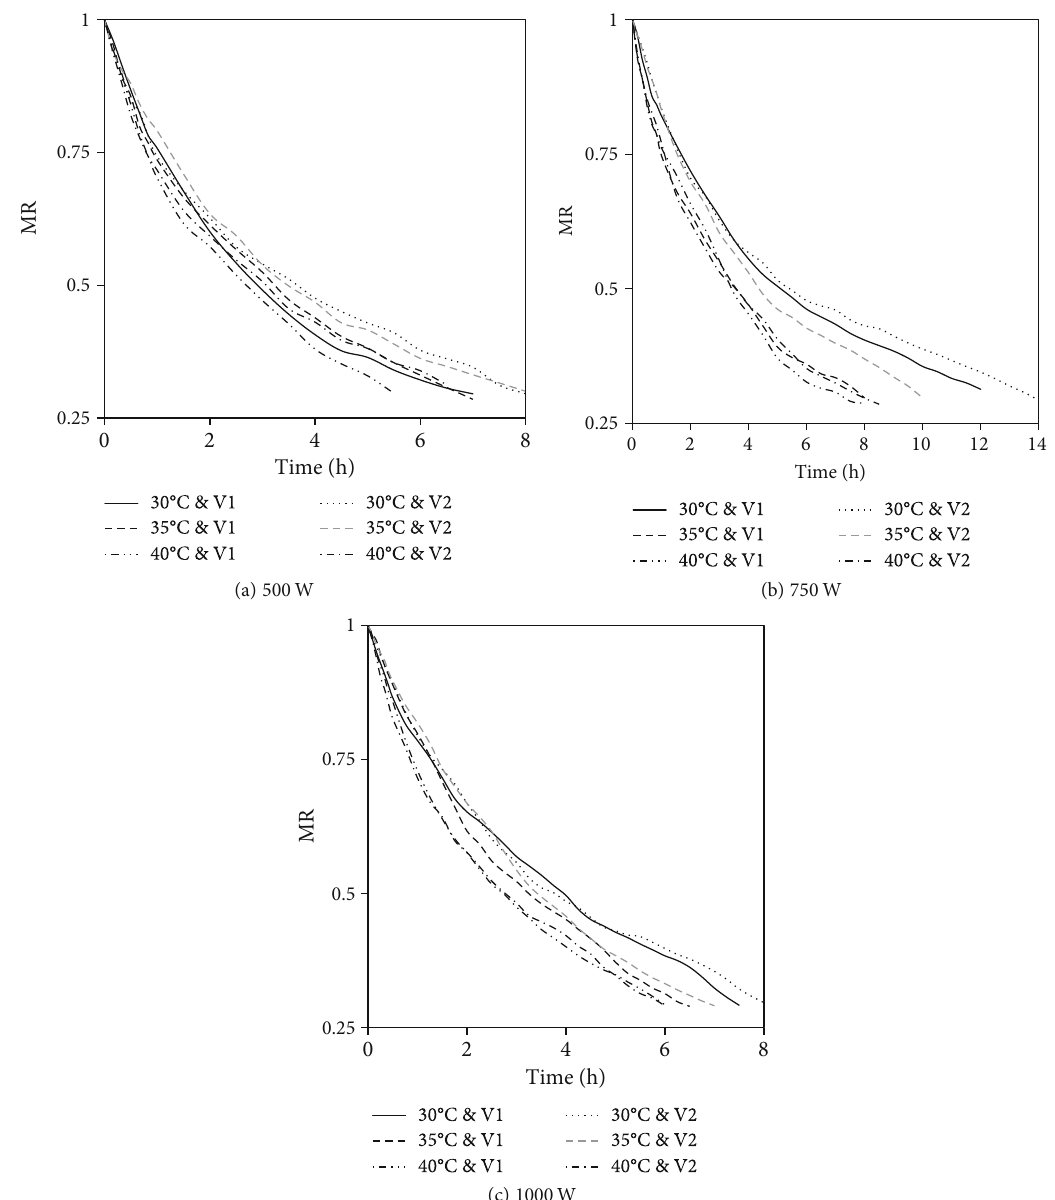
Figure 3: Variation in the MR of marinated beef during